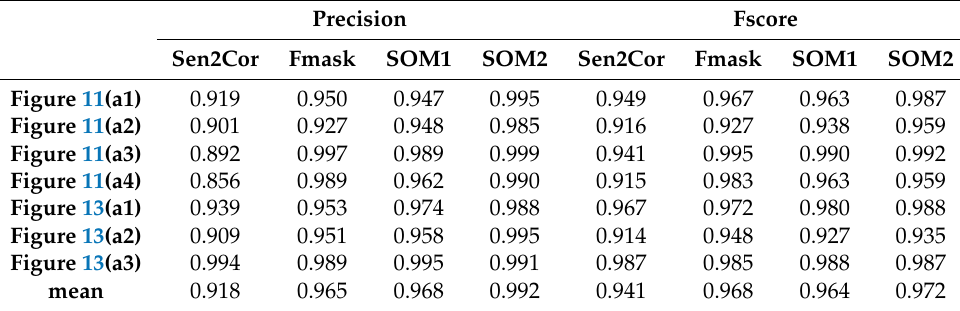
Table 6. Evaluation metrics of images with bright non-cloud objects (precision, fscore). Precision